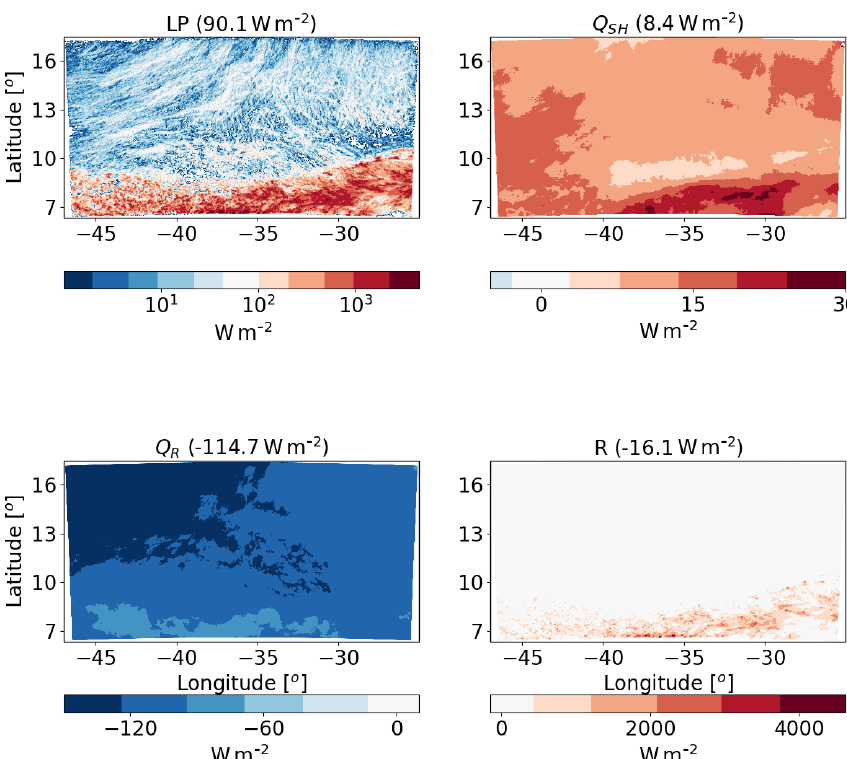
Figure 4. Spatial distribution of the time mean of the different terms of the energy budget for the ICON simulation of the shallow-cloud- dominated case (10–12 August 2016) with CDNC = 20cm − 3 . The terms that appear here are as follows: LP – latent heat by precipitation, Q SH – sensible heat flux, Q R – atmospheric radiative warming – and R – the energy imbalance. The domain- and time-mean value of each term appear in